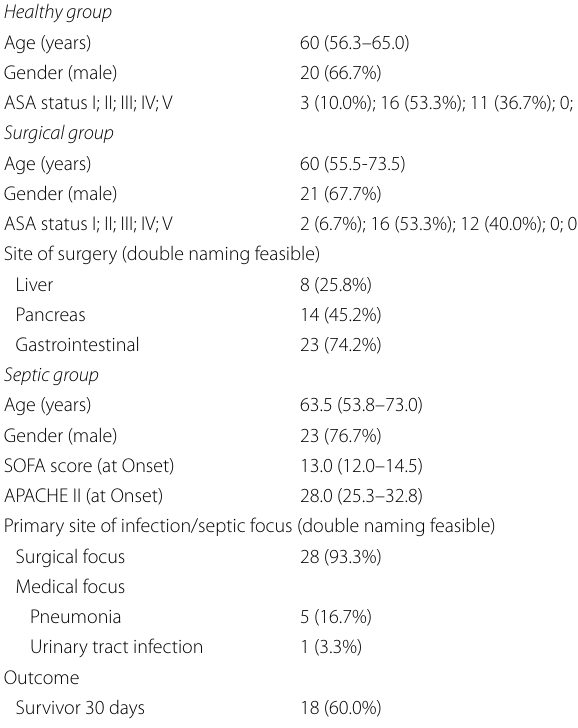
Table 1 Patients’